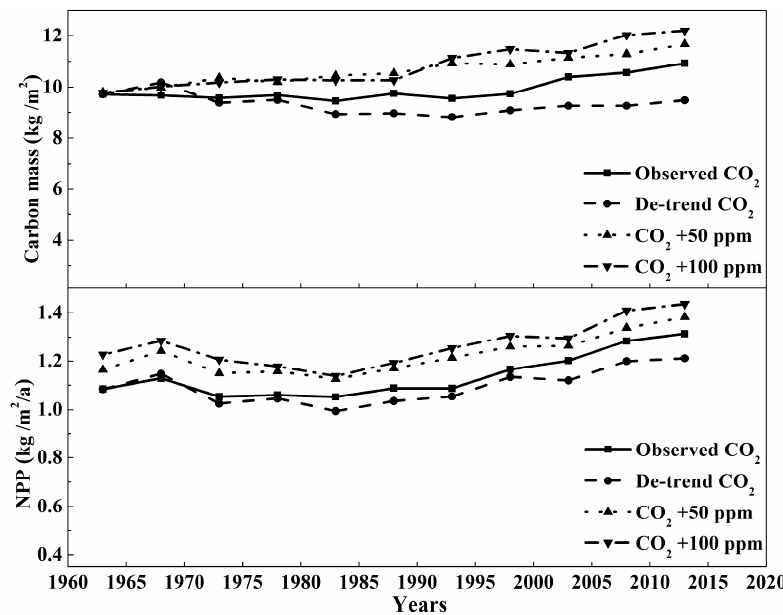
Figure 6. LPJ-GUESS output showing the effect on stored carbon (top panel) and NPP (bottom panel) of changing CO 2 concertration only. CO 2 concertration was de-trended by using 1964 levels throughout and was modified by adding values to each year value. Lines represent the means of simulations.